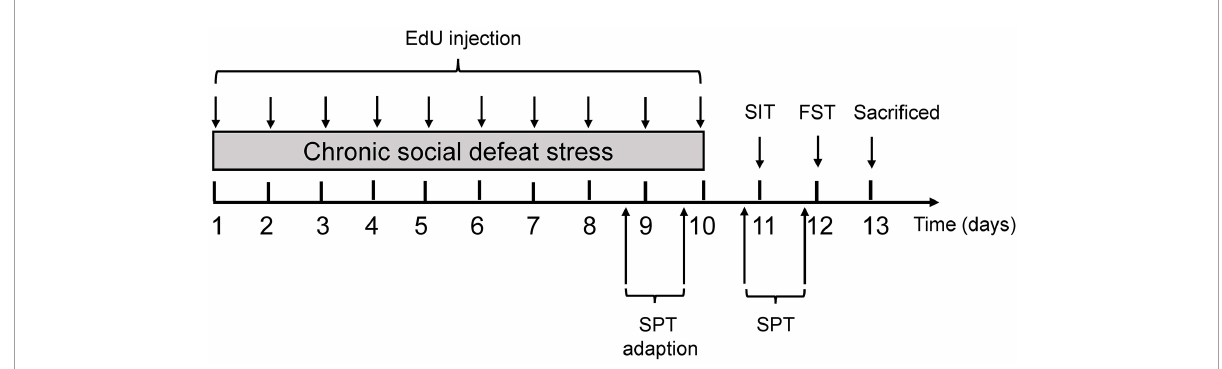
FIGURE1 Experimental procedures. Experimental procedure for the chronic social defeat stress (CSDS) paradigm in mice. 5-ethyl-2 (cid:48) -deoxyuridine (EdU) was administered intraperitoneally throughout the 10 days of CSDS to label proliferating cell populations, followed by behavioral tests. Mice were sacrificed for immunofluorescence staining to detect oligodendrocyte pathology after behavioral tests. EdU, 5-ethyl-2 (cid:48) -deoxyuridine; SIT, social interaction test; FST, forced swimming test; SPT, sucrose preference